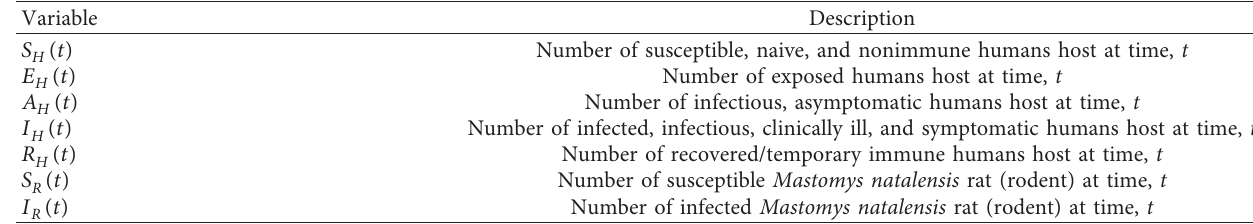
Table 1: Description of the state variables in the Lassa-fever model. Variable